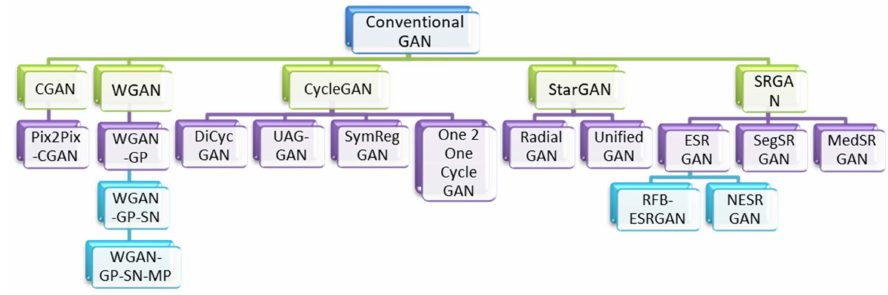
Figure 11. Major GAN variants and their